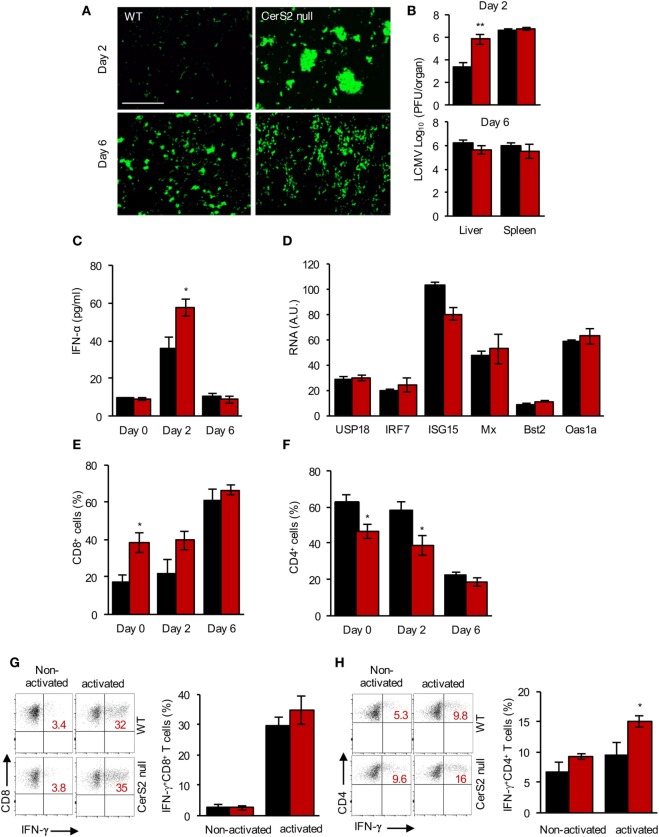
Increased susceptibility of ceramide synthase 2 (CerS2)-null mice to LCMV infection. (A) Representative images of wild-type (WT) and CerS2-null liver stained with an anti-LCMV antibody after infection with 2 × 106 plaque-forming units LCMV-WE for 2 and 6 days. Scale bar, 20 µm. (B) Viral titers 2 and 6 days post-infection (DPI). The experiment was repeated two times with similar results. (C) IFNα levels were measured in a liver homogenate (5 mg protein/ml homogenate) in the liver 2 and 6 DPI. (D) qPCR of downstream target genes of IFNR1 signaling 2 DPI in the liver of WT and CerS2-null mice. (E) Total CD8+ and (F) CD4+ (percent of total CD3+) T cells in the liver of WT and CerS2-null mice 2 and 6 DPI. (G) Representative flow cytometry plots and quantitation of intracellular staining of non-activated (without peptide) and activated (LCMV-specific peptide GP33) IFNγ-producing CD8+ (percent of total CD8+ cells) and (H) non-activated and activated (LCMV-specific peptide GP64) CD4+ (percent of total CD4+) cells. Liver hematopoietic cells from LCMV-infected mice 6 DPI were isolated and restimulated in vitro with LCMV-specific peptides. n = 3 per group. Black columns, WT; red columns, CerS2 null.